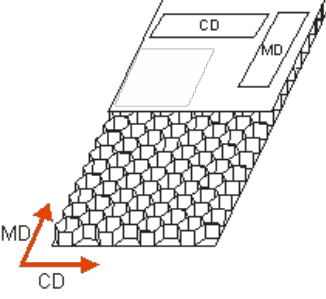
Figure 4. Method for cutting samples.